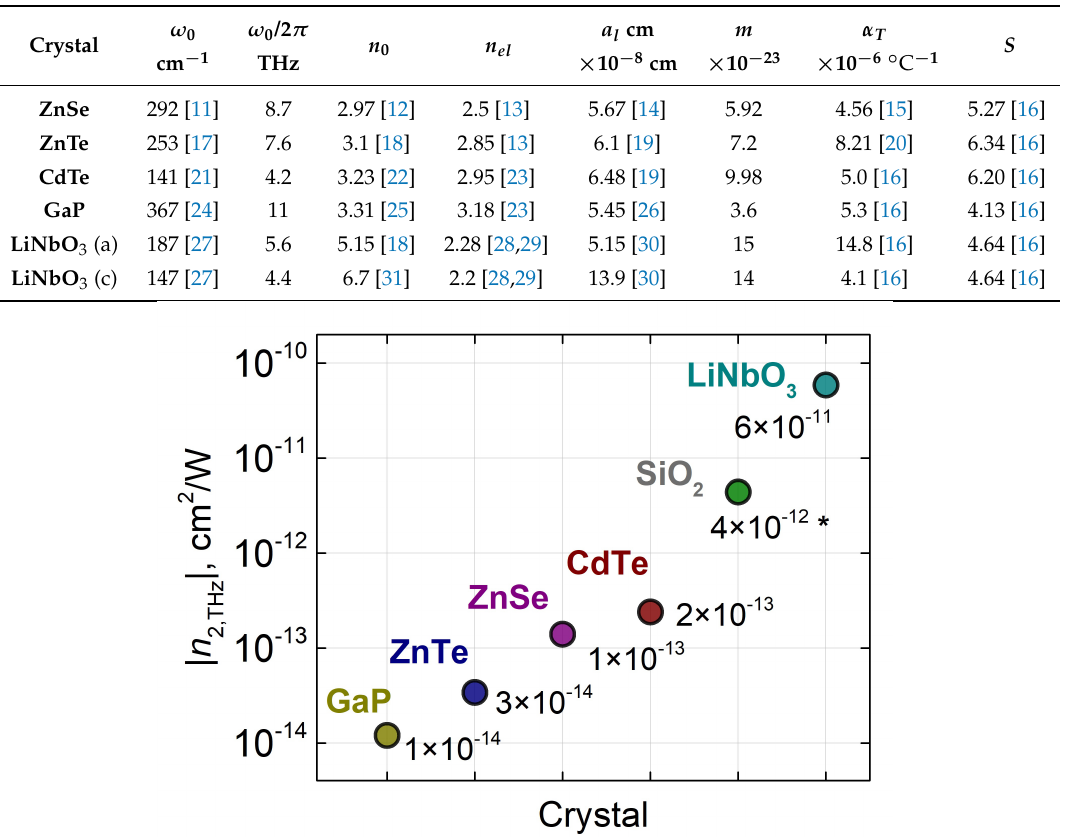
Figure 1. The results of n 2, THz estimations (see also Table 2) for comparison with other results), * calculated value from [7]. Table 2. The nonlinear refractive index coefficients in the NIR and the THz frequency